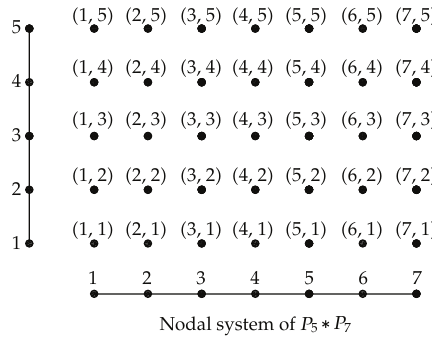
Figure 3: Nodal coordinate system of the Boolian product of P 7 and P 5 .